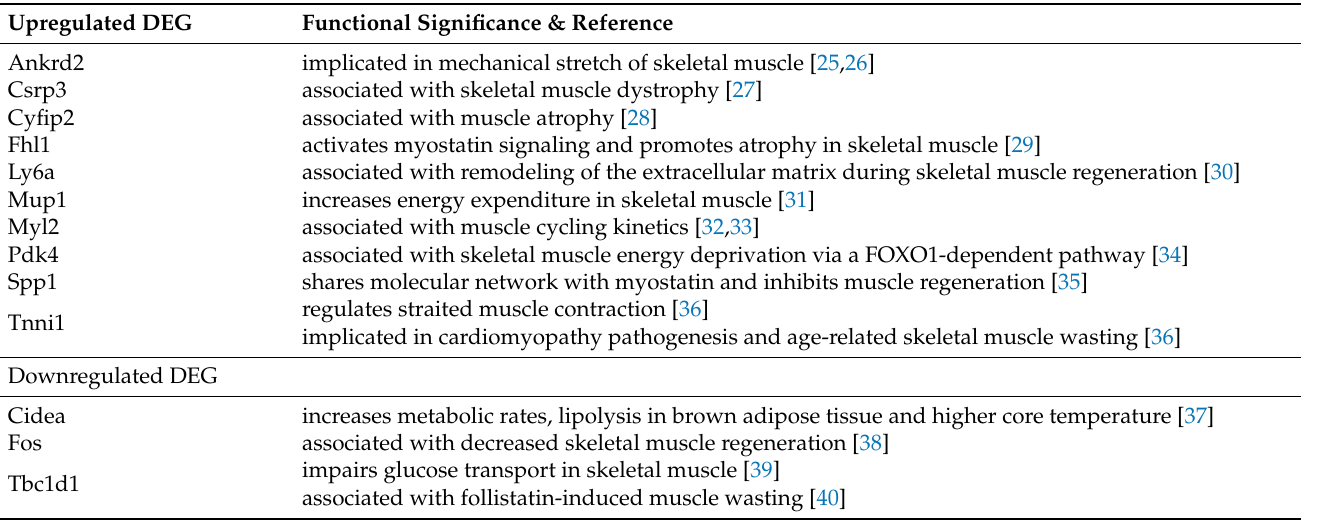
Table 2. PLA normalizes or attenuated expression of important muscle genes in Ctns − / − mice. Functional significance for each of these differentially expressed muscle genes is listed. DEG, differential expressed